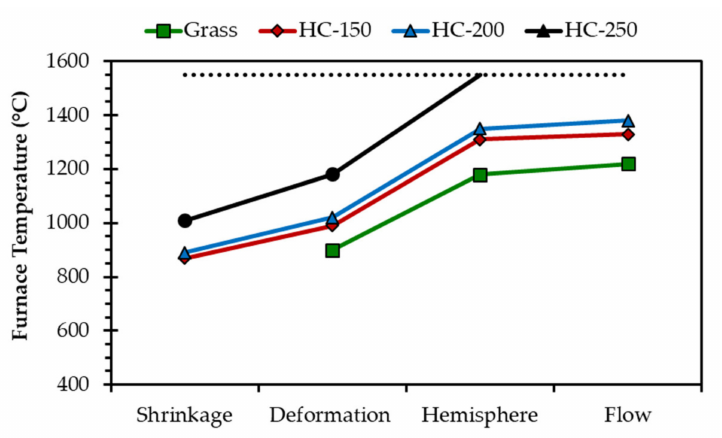
Figure 4. Ash fusion transition temperatures for grass and hydrochars. The dotted line indicates the temperature limit of the furnace (1550 ◦